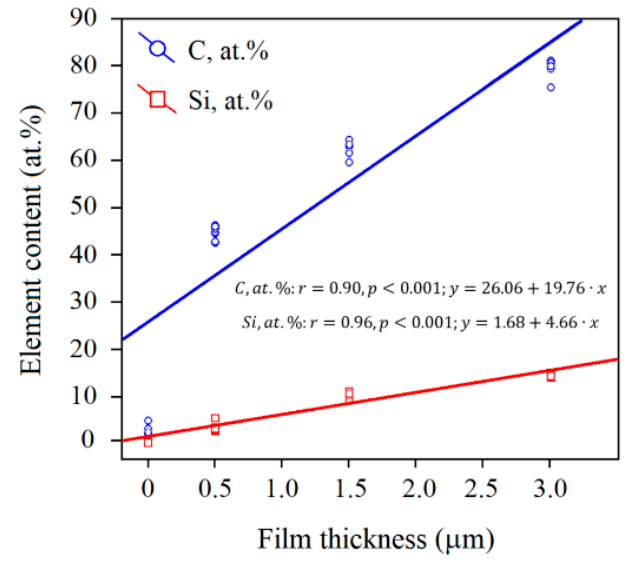
Figure 7. Dual regression dependences of C and Si content in a-C:H:SiO x -coated Ti-6Al-4V substrate on the film thickness after five-week immersion in 0.9% NaCl solution. The EDX data are shown on the Y